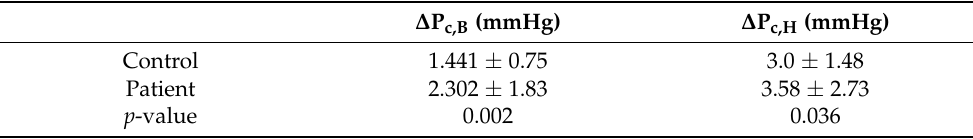
Table 3. The results (mean ± standard deviation) of D B,max , D H,max , D B,min , and D H,min measured by BAUS.